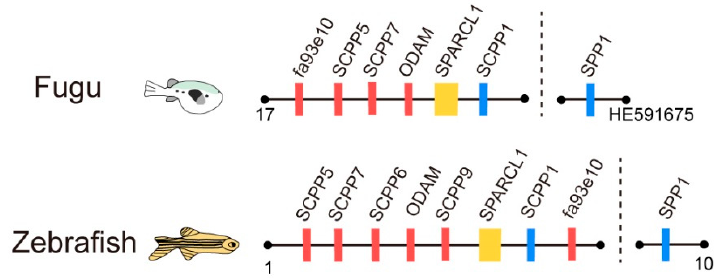
Figure 1. The SPARCL1 - SCPP cluster in fugu and zebrafish (modified from [10,11]).